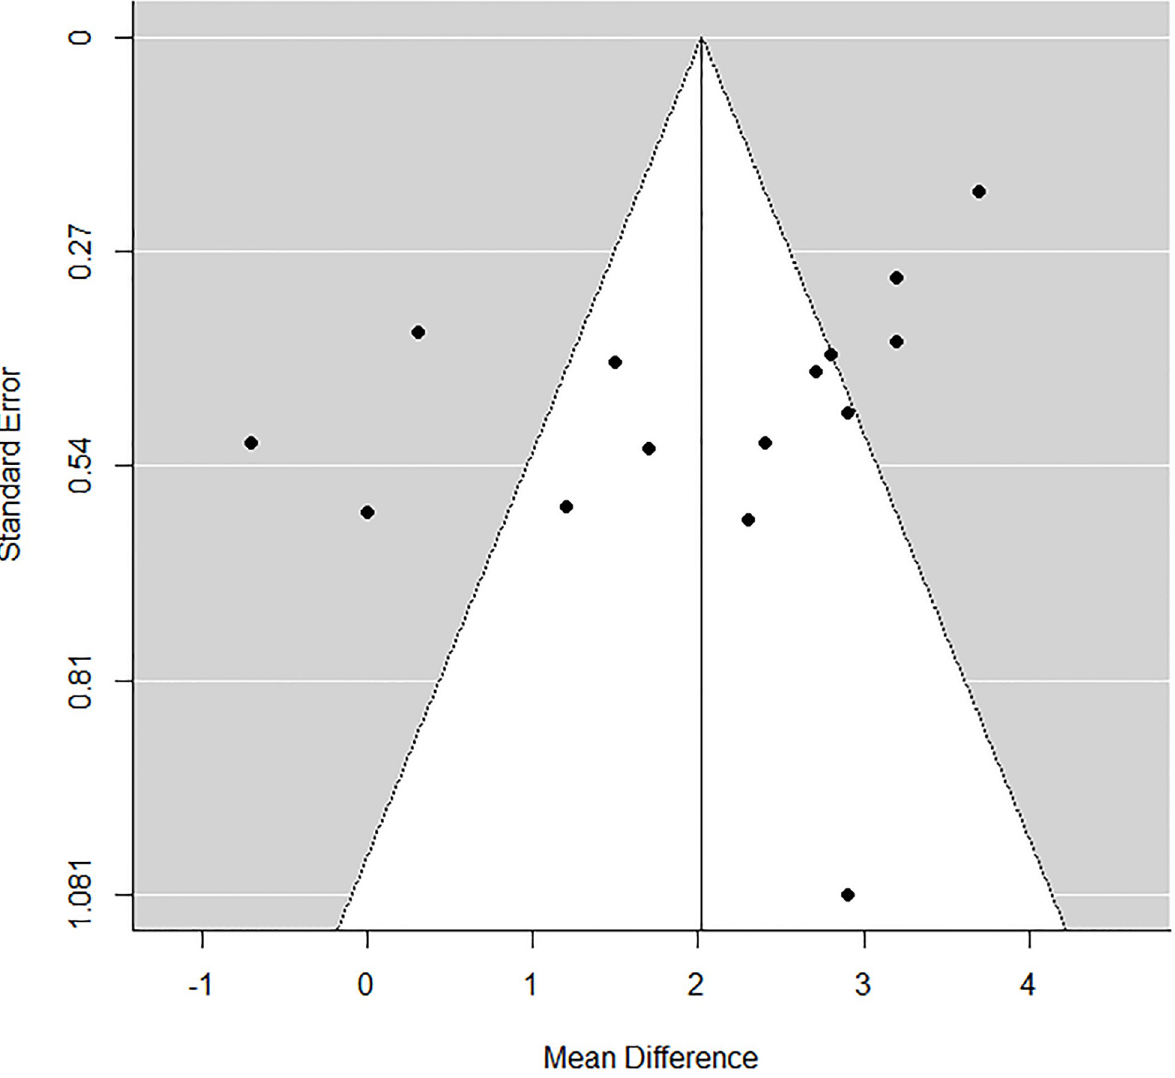
Fig 4. The Funnel plot analysis of the studies included in the